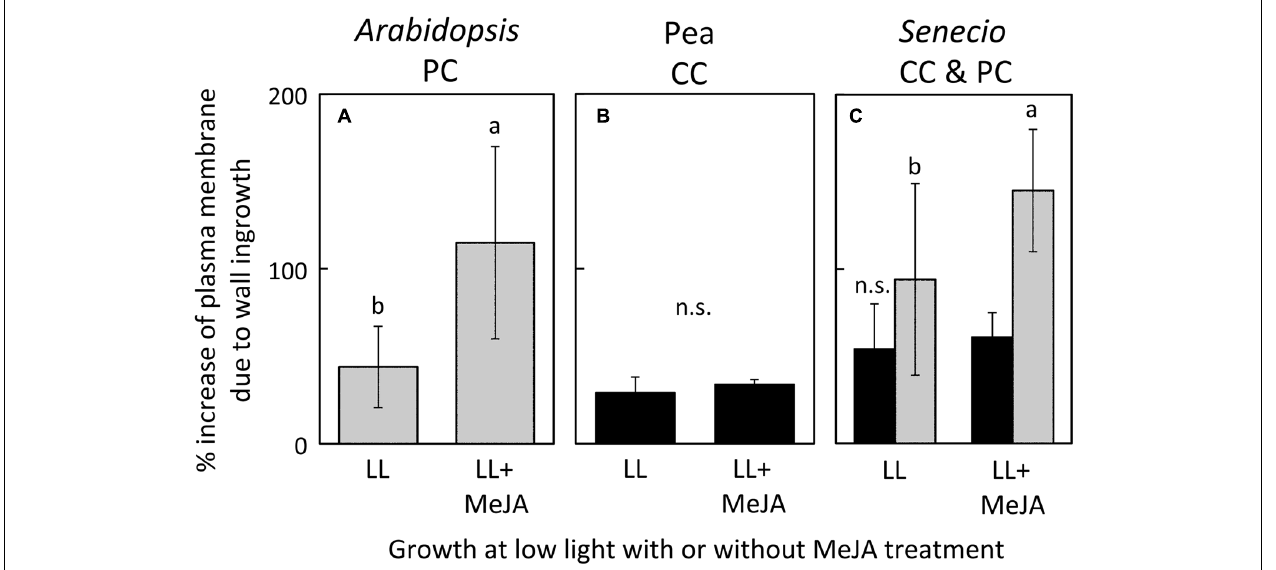
FIGURE 6 | Percent increase in plasma-membrane length due to cell-wall ingrowths estimated from cross-sections of phloem transfer cells (parenchyma = PC, companion = CC) relative to the hypothetical membrane area in the absence of wall ingrowths in foliar minor veins of A. thaliana (A), pea (B), and S. vulgaris (C) that developed in low light and were sprayed with a 0.05% solution of Tween (LL) or a 0.05% solution of Tween with 10 μ M